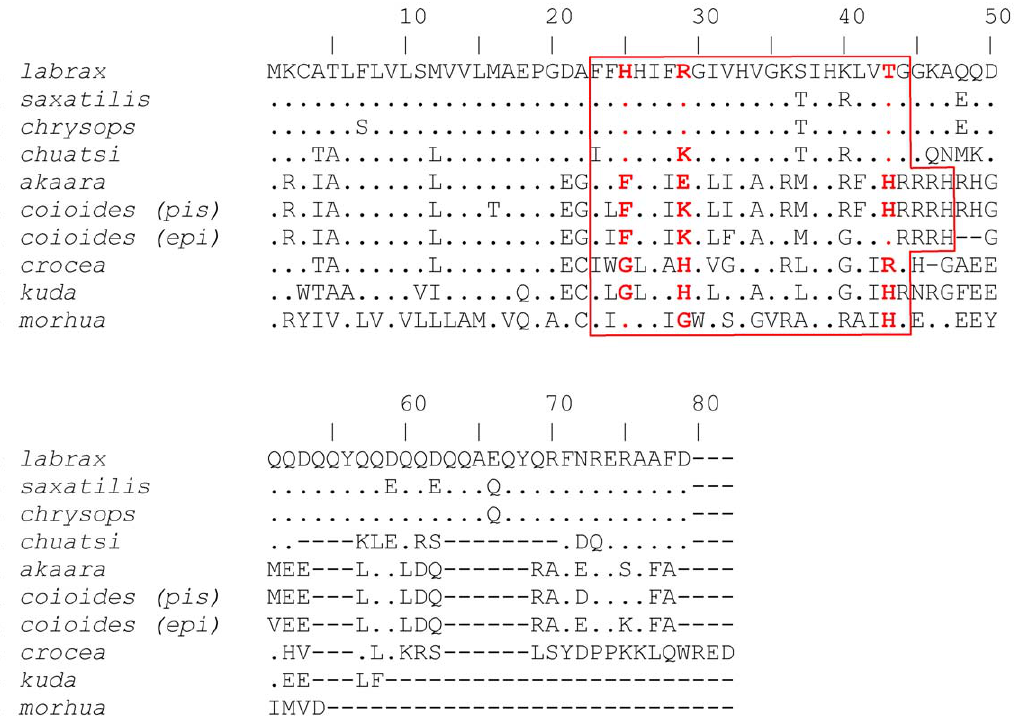
Figure 1. ClustalW multiple sequence alignment of putative piscidin peptides from teleosts. Amino acid residues identical to D. labrax piscidin are represented by a dot and alignment gaps are indicated by a dash. The mature peptides are boxed and positively selected residues are highlighted in bold red.